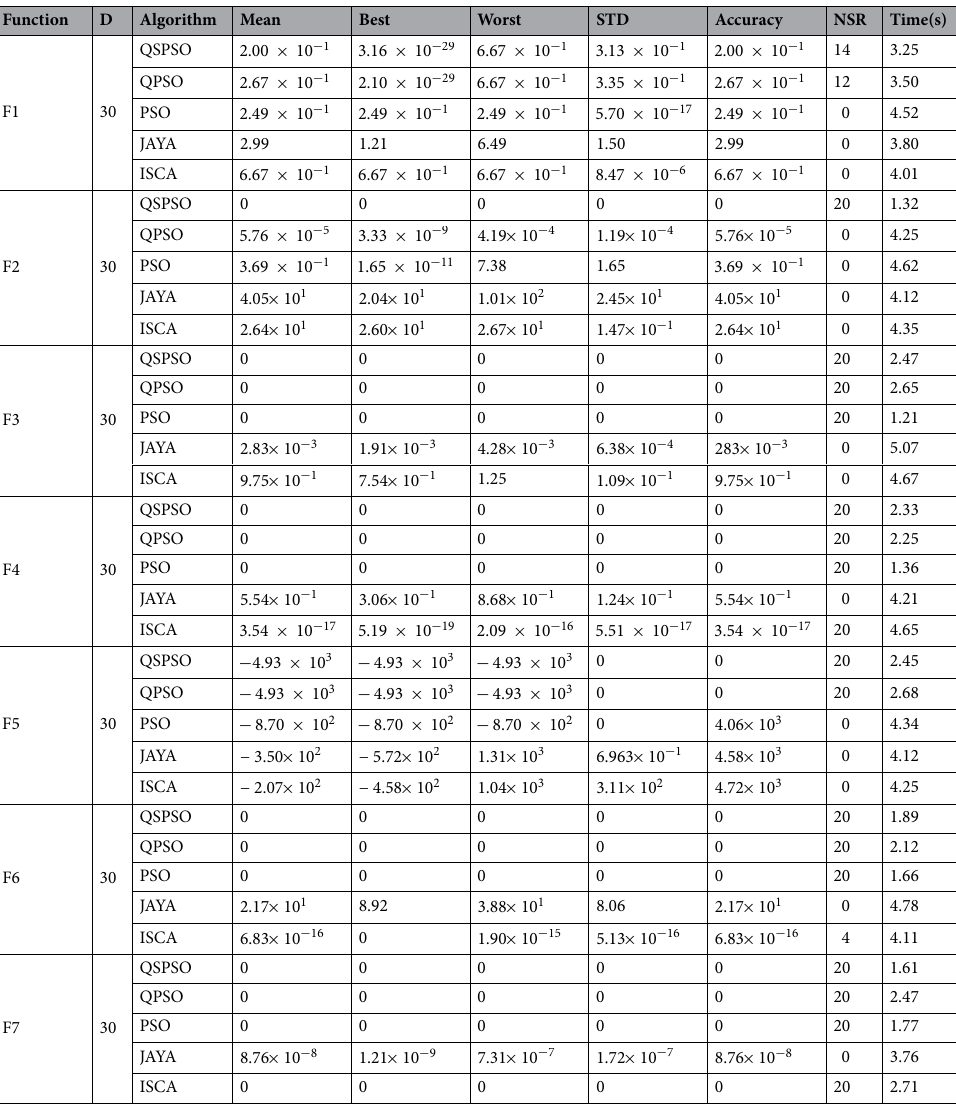
Table 2. Numerical results for unimodal benchmark